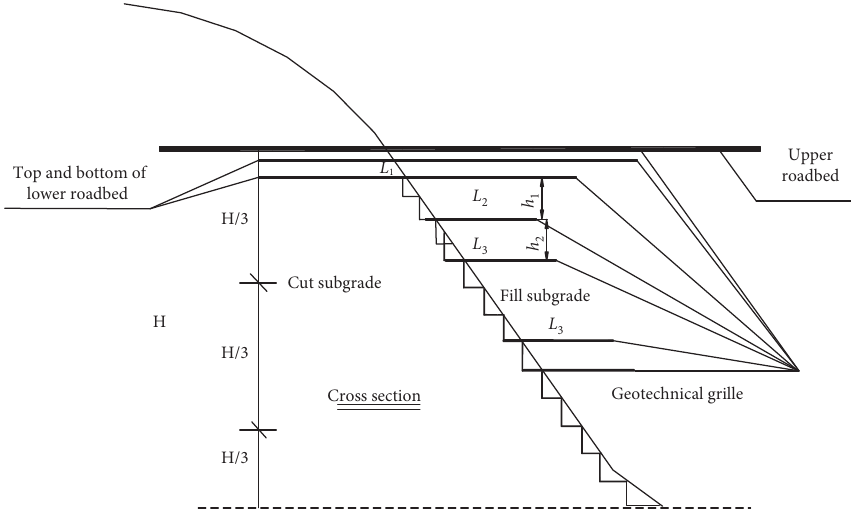
Figure 13: Schematic diagram of geogrid layout scheme for longitudinal cut to fill location. Table 10: Geogrid paving scheme parameters for longitudinal cut to fill location. Vehicle speed (km/h)